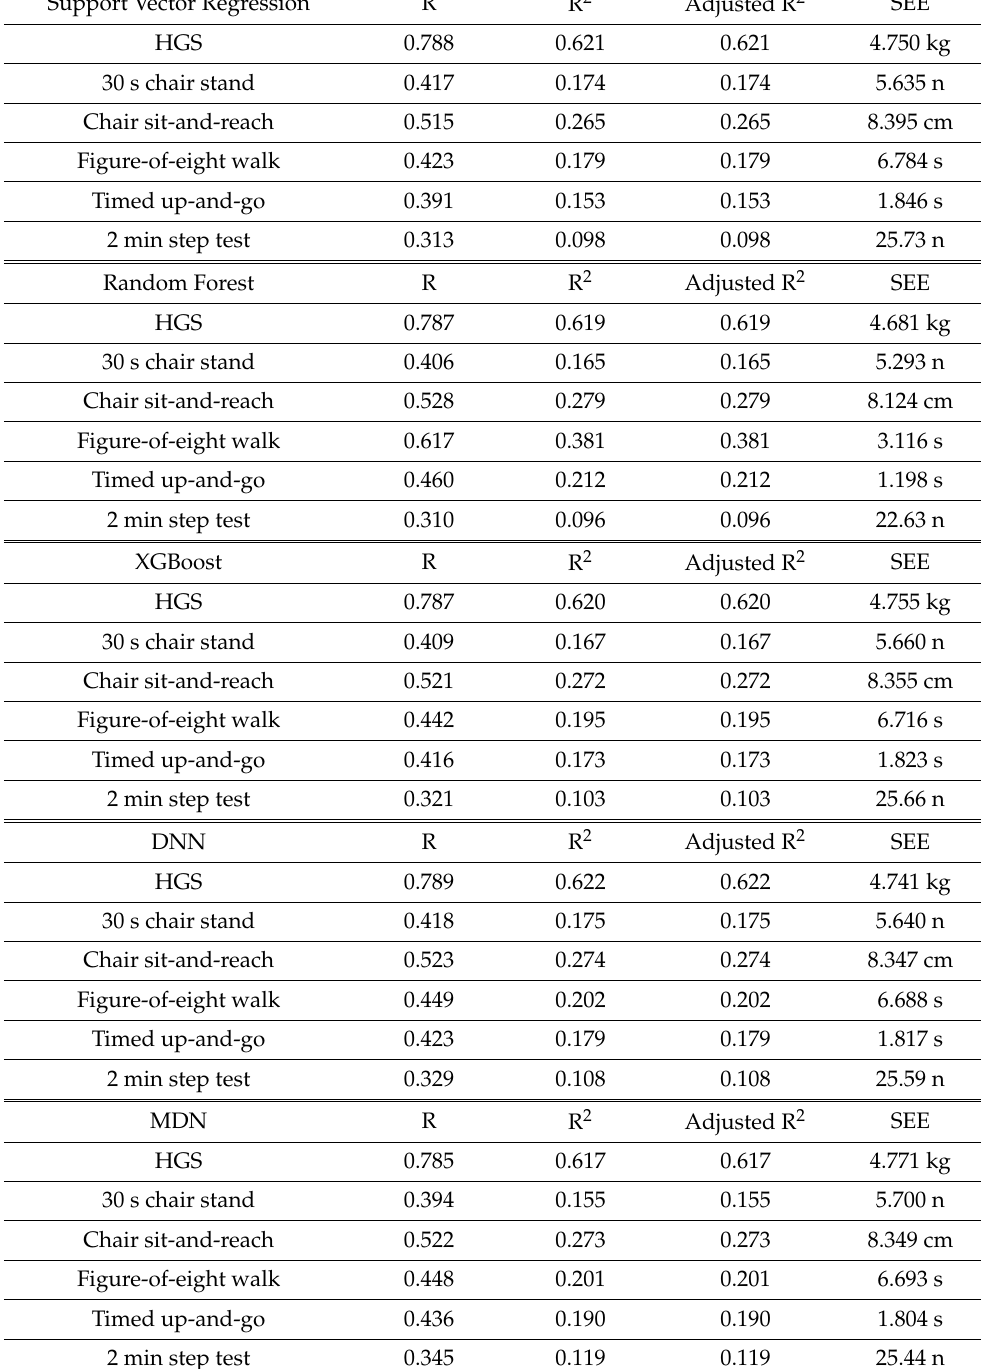
Table 4. Comparison of the estimated regression models predicting the FF